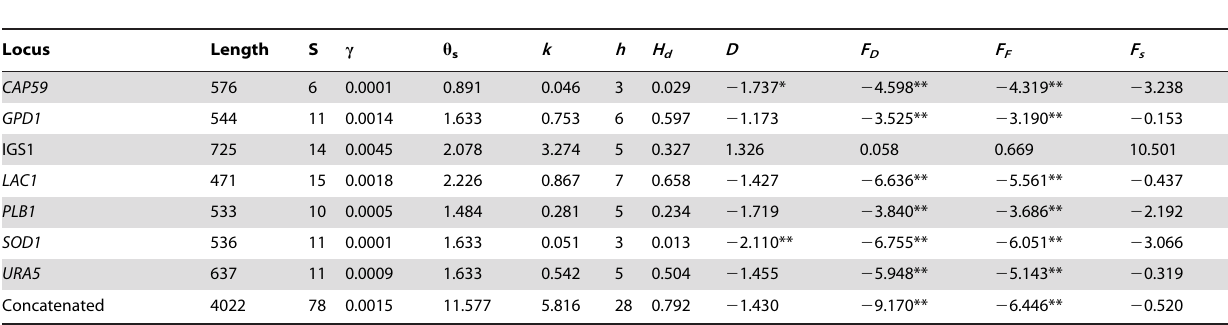
Table 6. DNA polymorphisms in each MLST locus and concatenated sequences of Asian C . neoformans var. grubii isolates.